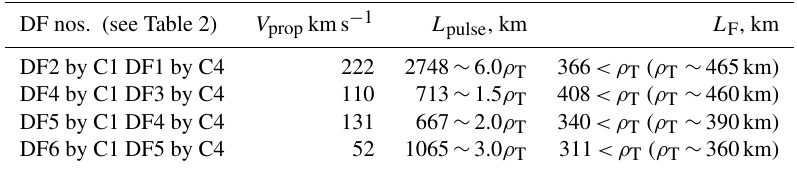
Table 4. Propagation velocity ( V prop ) of the B Z pulses (DFs), the spatial scale of the pulse structure ( L S ) and the thickness of the fronts ( L F ) calculated for several B Z pulses observed by C1 and C4 during the dipolarization. DF nos. (see Table 2) V prop kms − 1 L pulse , km L F , km DF2 by C1 DF1 by C4 222 2748 ∼ 6.0 ρ T DF4 by C1 DF3 by C4 713 ∼ 1.5 ρ T 131 667 ∼ 2.0 ρ